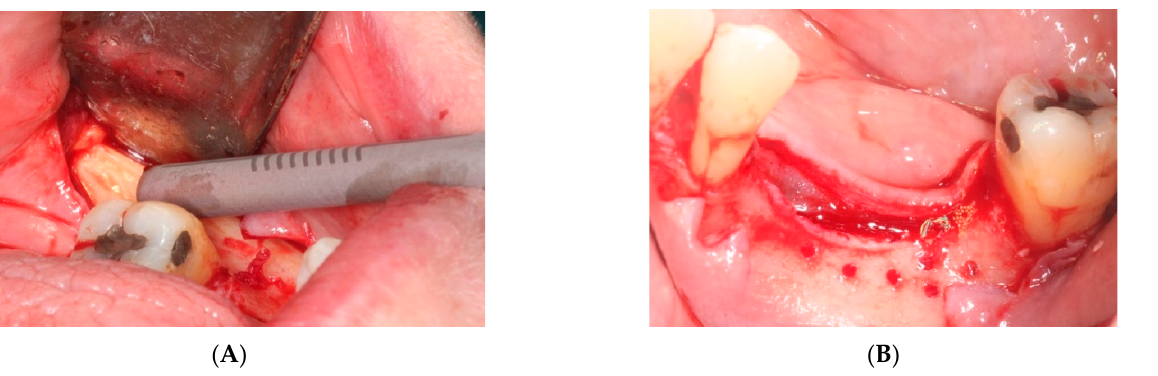
Figure 4. ( A ) Obtaining autologous bone from the mandibular ramus. ( B ) Perforations in the mandibular bone with a #6 tungsten carbide bur.